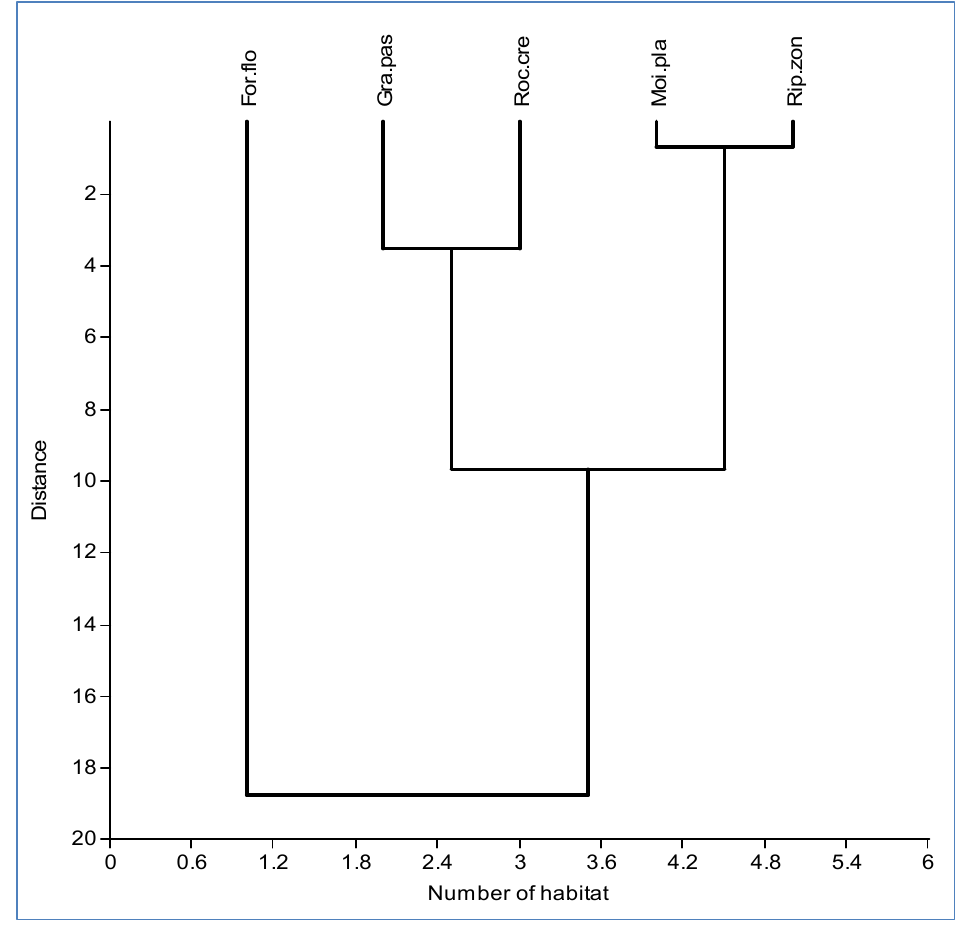
Figure 4. Clustering of documented species in different habitat in the study area. More than half of the species (56%), including Pteris cretica, Adiantum tibeticum , Adiantum venustum , and Adiantum capillus ‐ veneris, were reported from altitudes below 2000 m, 19% from 2001–2500 m (e.g., Asplenium fontanum, Thelypteris microstegia, Deparia japonica, Deparia petersenii ), 17% of the species (e.g., Athyrium dubium, Lepisorus clathratus ) from 2501–3000 m, and 8% (e.g., Deparia allantodioides, Dryopteris xanthomelas, Asplenium viride ) from 3001–3500 m (Figure 5). A circular layout of the diagram represents the documented species and altitudinal ranges, and its inner lines represent the relationship between the species and altitude. The lines connecting each species and altitude represent their importance in relation to each other, and the size of the arc reflects the number of species in each category. The histogram illustrates the number of species in the landscape, with the greater species numbers (32) in the lower (below 2000 m) altitudes (Figure 6). When comparing the upper and middle altitudinal regions, the lower areas had higher species numbers. This may be due to the fact that a lower altitude provides diverse, suitable habitats for the growth of pteridophytes.